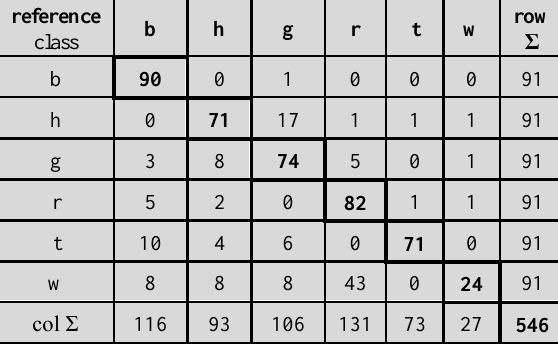
Table 2. Error matrix of the land cover map derived by a DT (b=’building’, h=’hedge&bush’, g=’grass’, r=’road&parking lot’, t=’tree’, w=’wall&car port’). Taken from (Höhle, 2014).